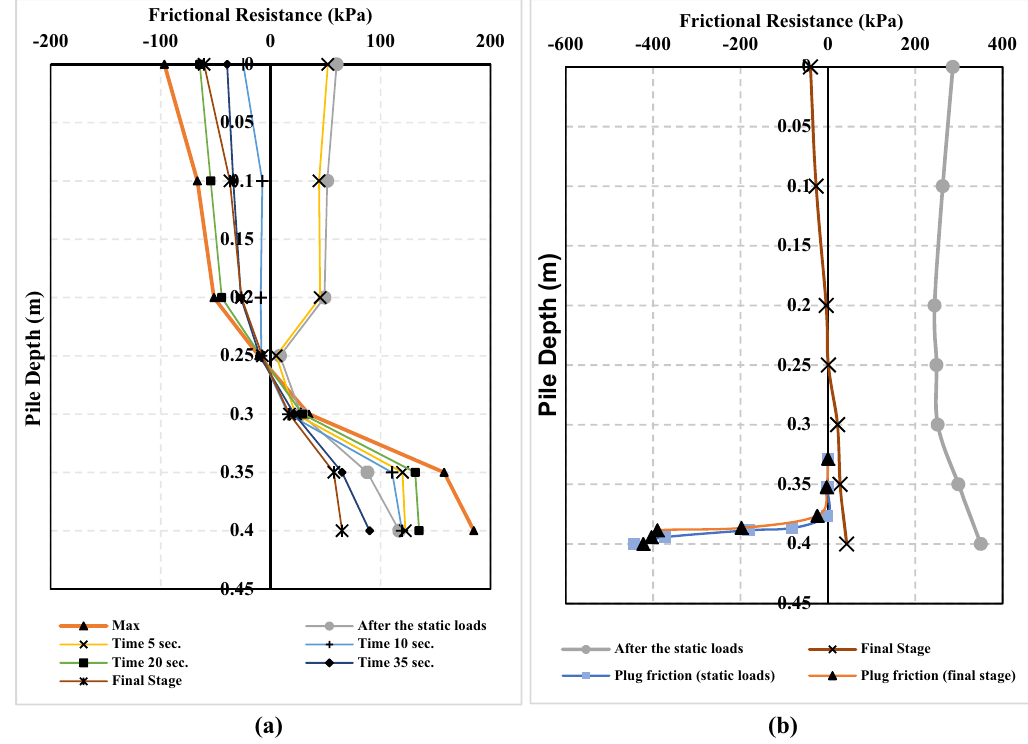
Figure 6: Frictional resistance along the pile length: ( a ) closed - ended pipe pile and ( b ) open - ended pipe